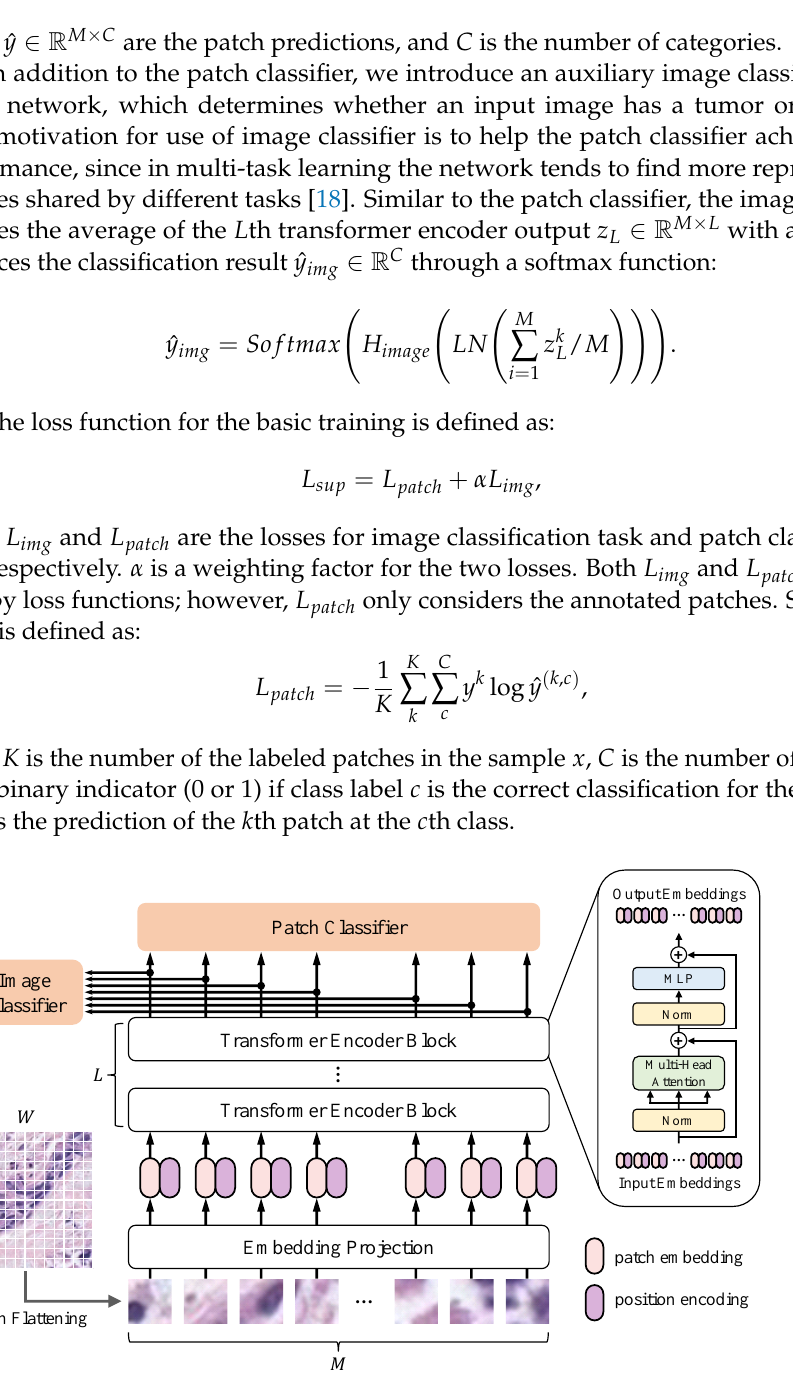
Figure 3. Illustration of PSeger (using Vistion Transformer as